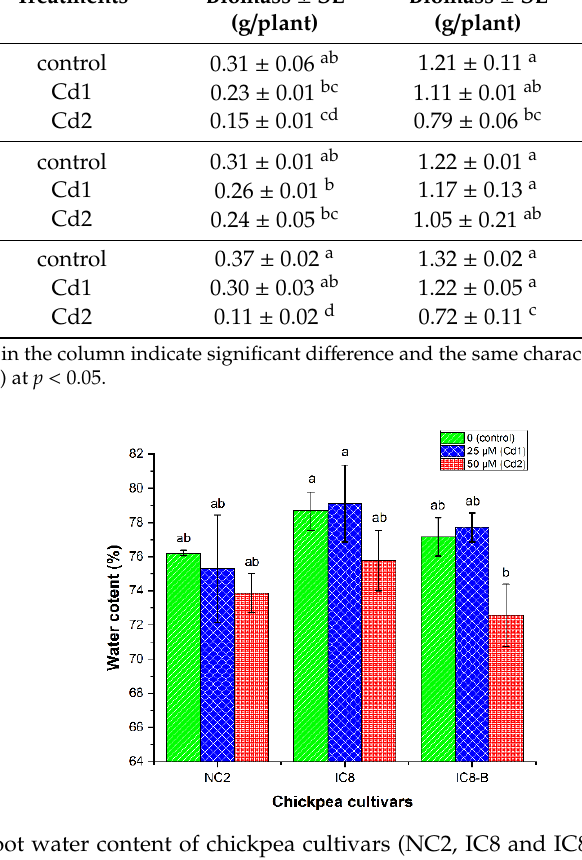
Figure 2. The shoot water content of chickpea cultivars (NC2, IC8 and IC8-B) exposed to various concentrations of Cd (0, 25 and 50 µM). The bars represent SE, n = 3. Columns with different characters are significantly different according to (DMRT) at p < 0.05.